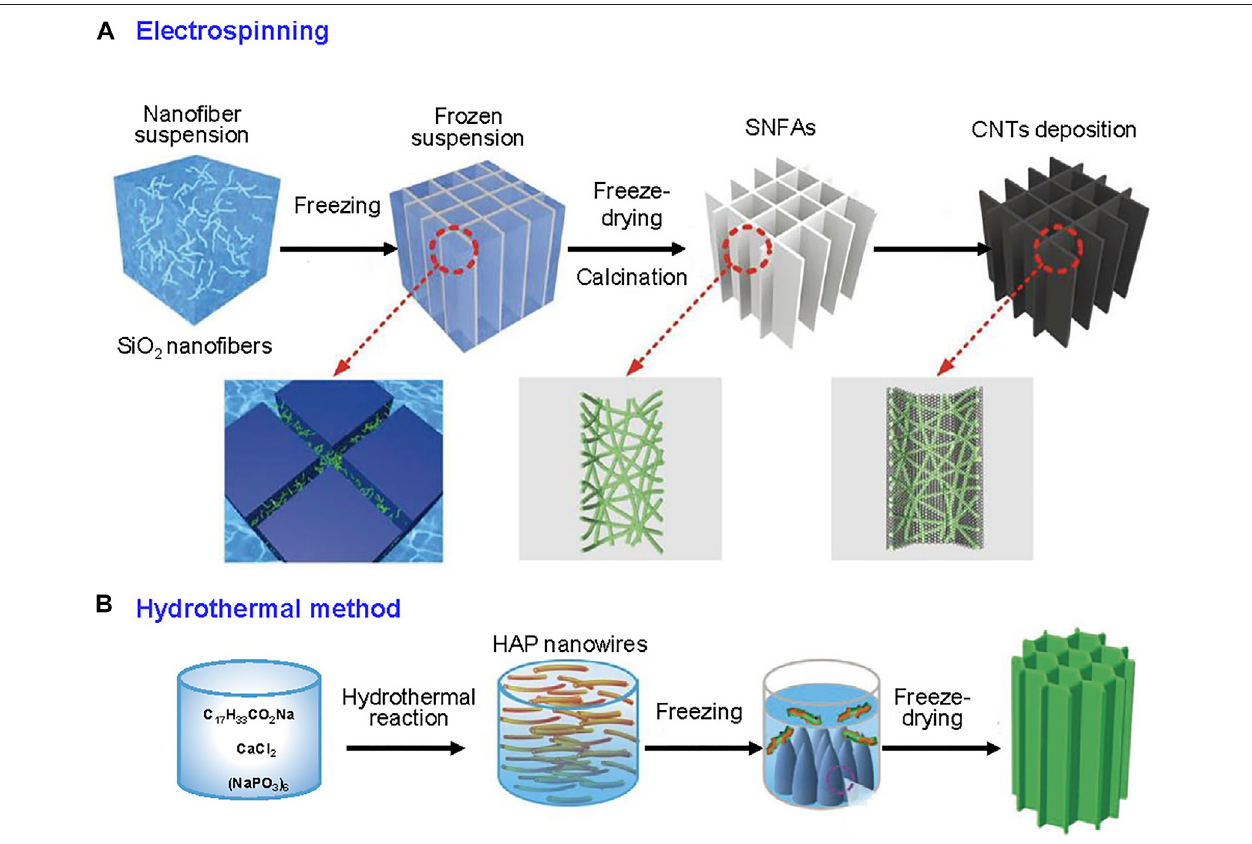
FIGURE5 | Inorganic nano fi bers asbuilding blocks for fi brous aerogels. (A) Fabrication principlesofthe SiO 2 nano fi brous aerogel. Reprinted withpermissionfrom (Dong et al., 2020). Copyright (2020) WILEY VCH. (B) Fabrication process of HAP nanowires and their corresponding aerogels. Reprinted with permission from